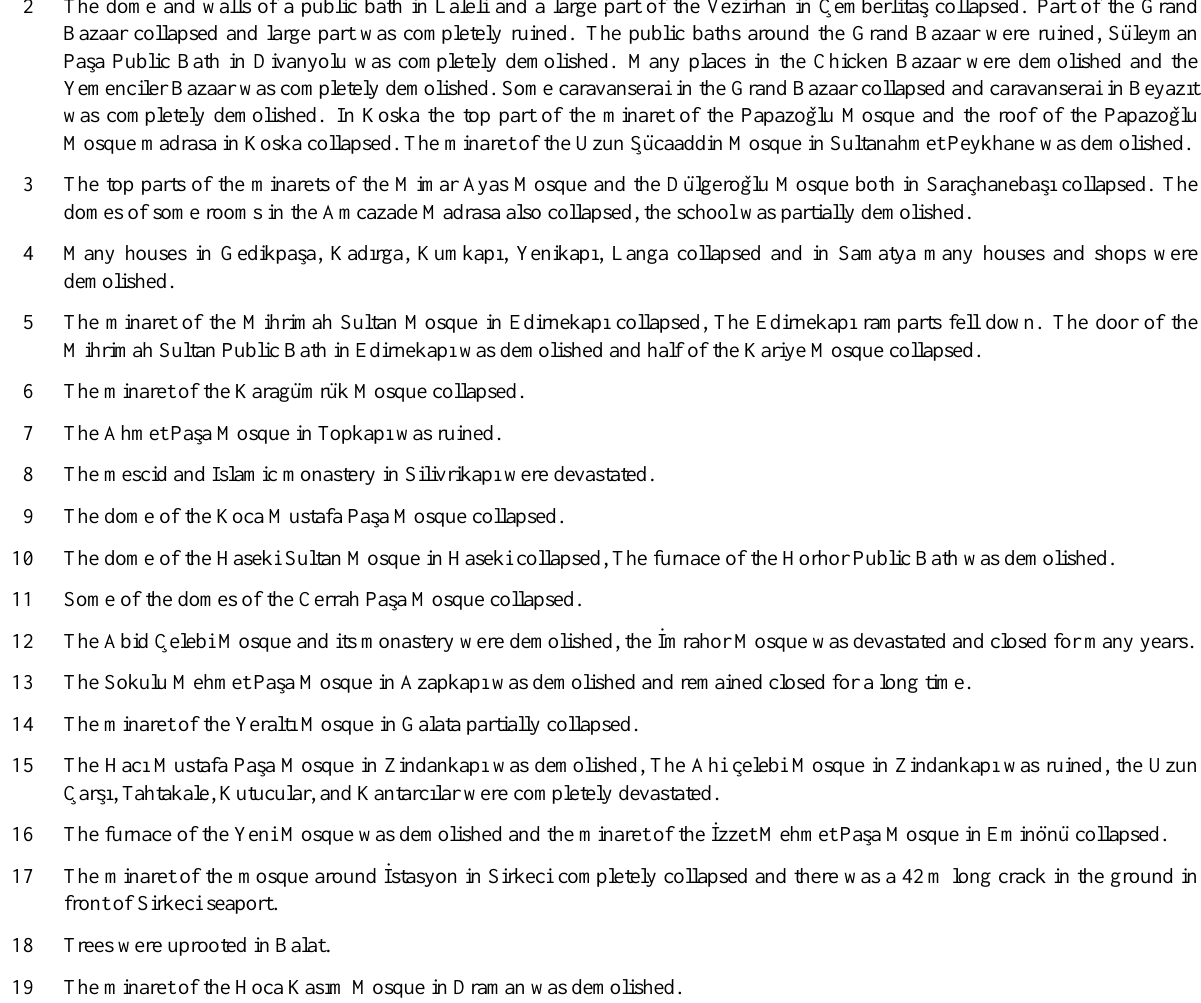
Table 6. Building damage reports from the 1894 earthquake (Lav,